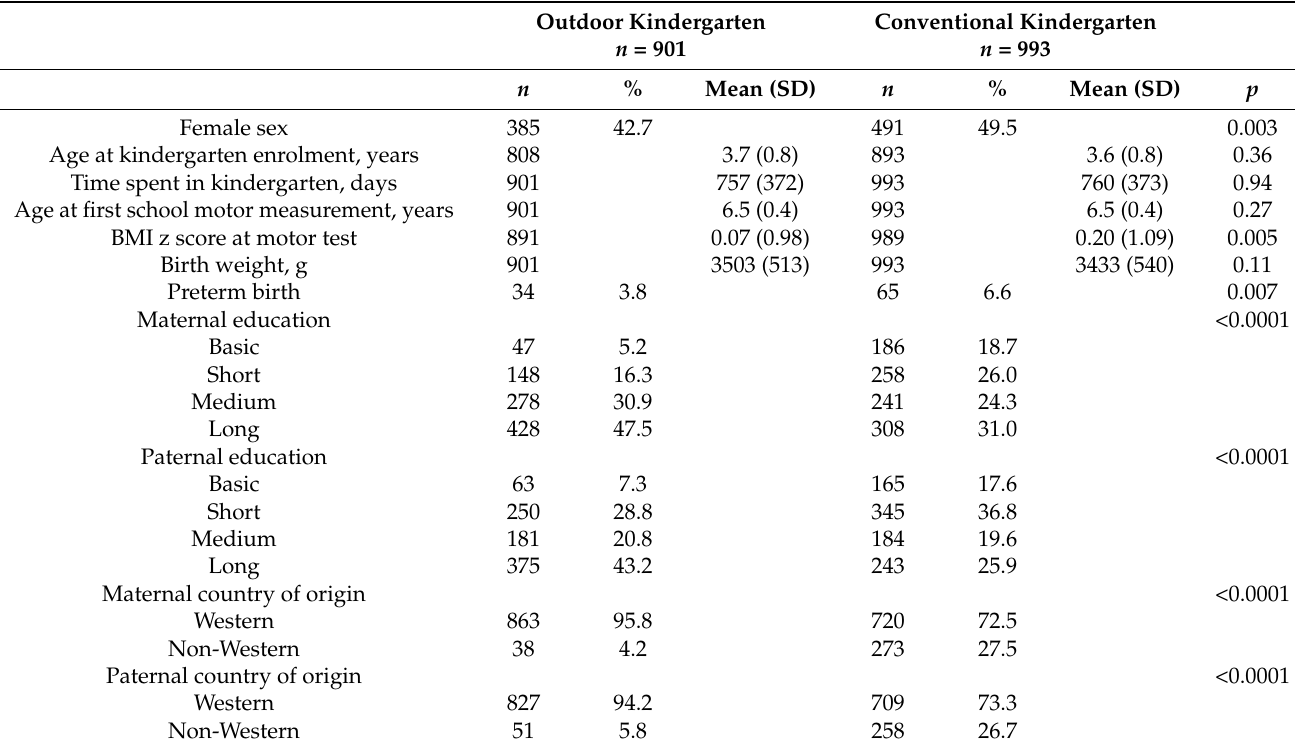
Table 1. Participant characteristics of children in outdoor kindergartens versus conventional kinder- gartens. Results are presented as percentage or mean and standard deviation